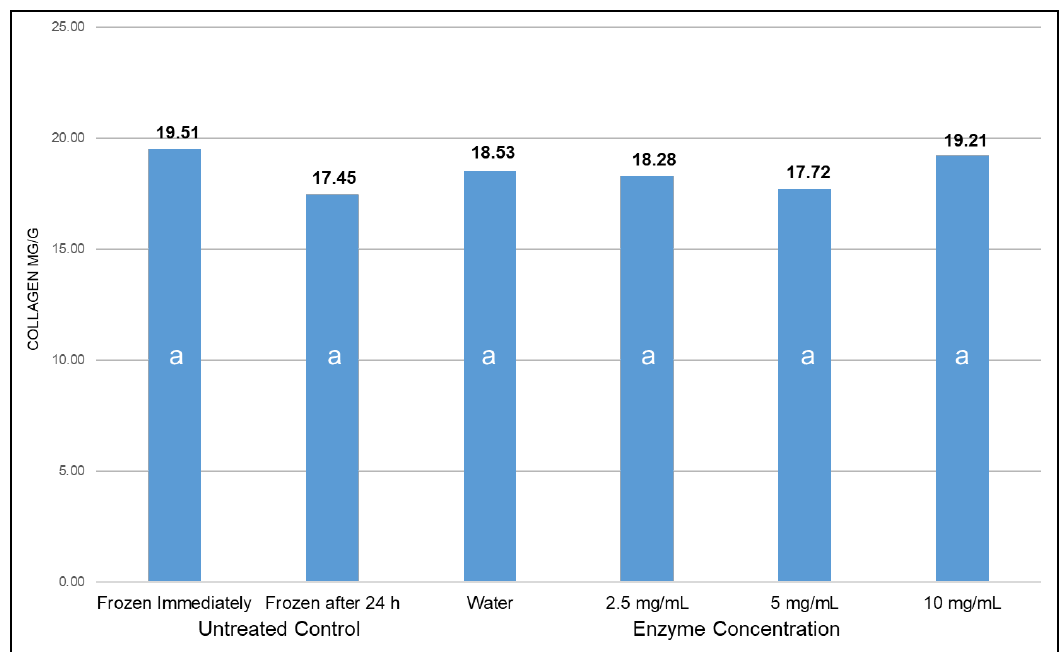
Figure 1. Effect of collagenase at different concentrations on total collagen (mg/g) in ground woody breast meat. Similar letters in the bar graph represent no significant differences among the treatments ( p > 0.05).